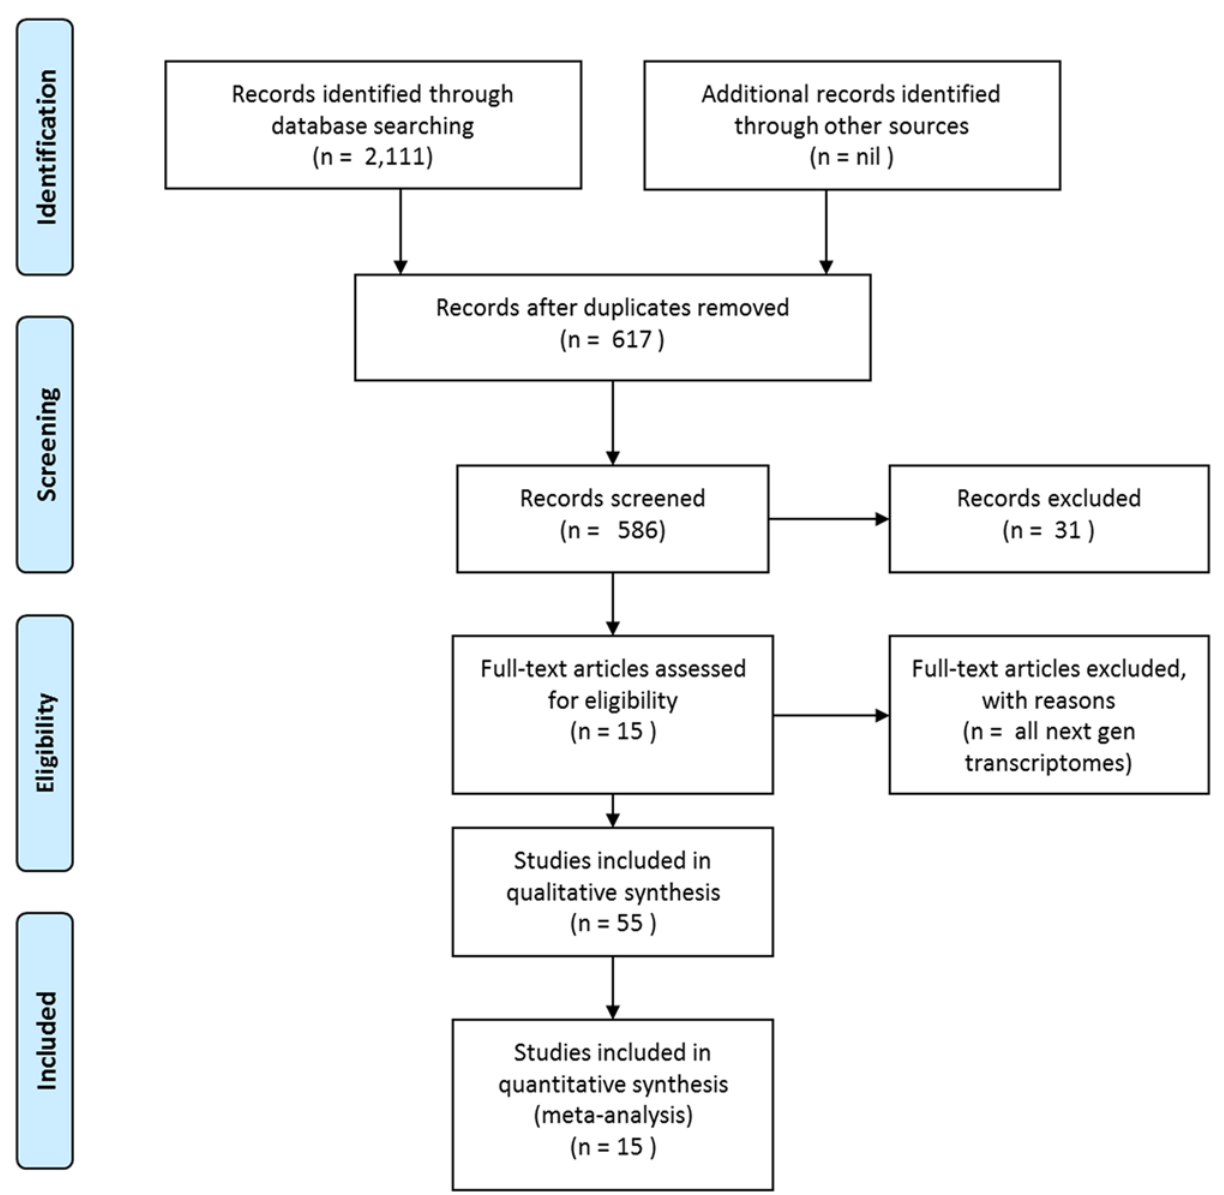
Fig 1. Schematic representation of the workflow used in this